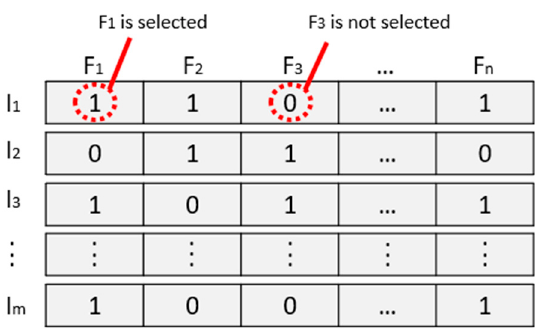
Figure 6. The BPSO process is represented by a particle. Algorithm 1: Pseudocode BPSO in Feature Selection.